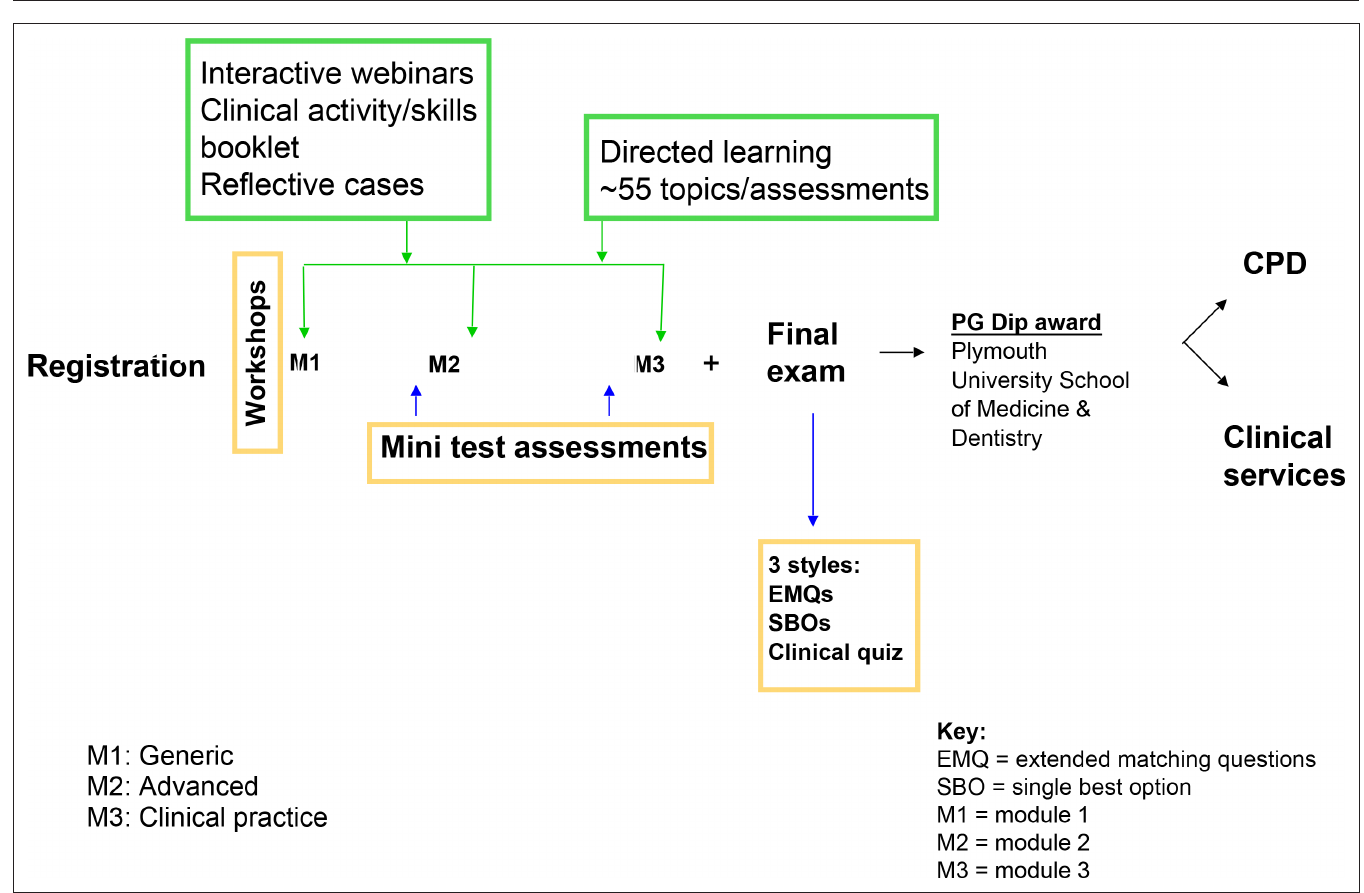
Figure 2 Structure of the Postgraduate Diploma in Family